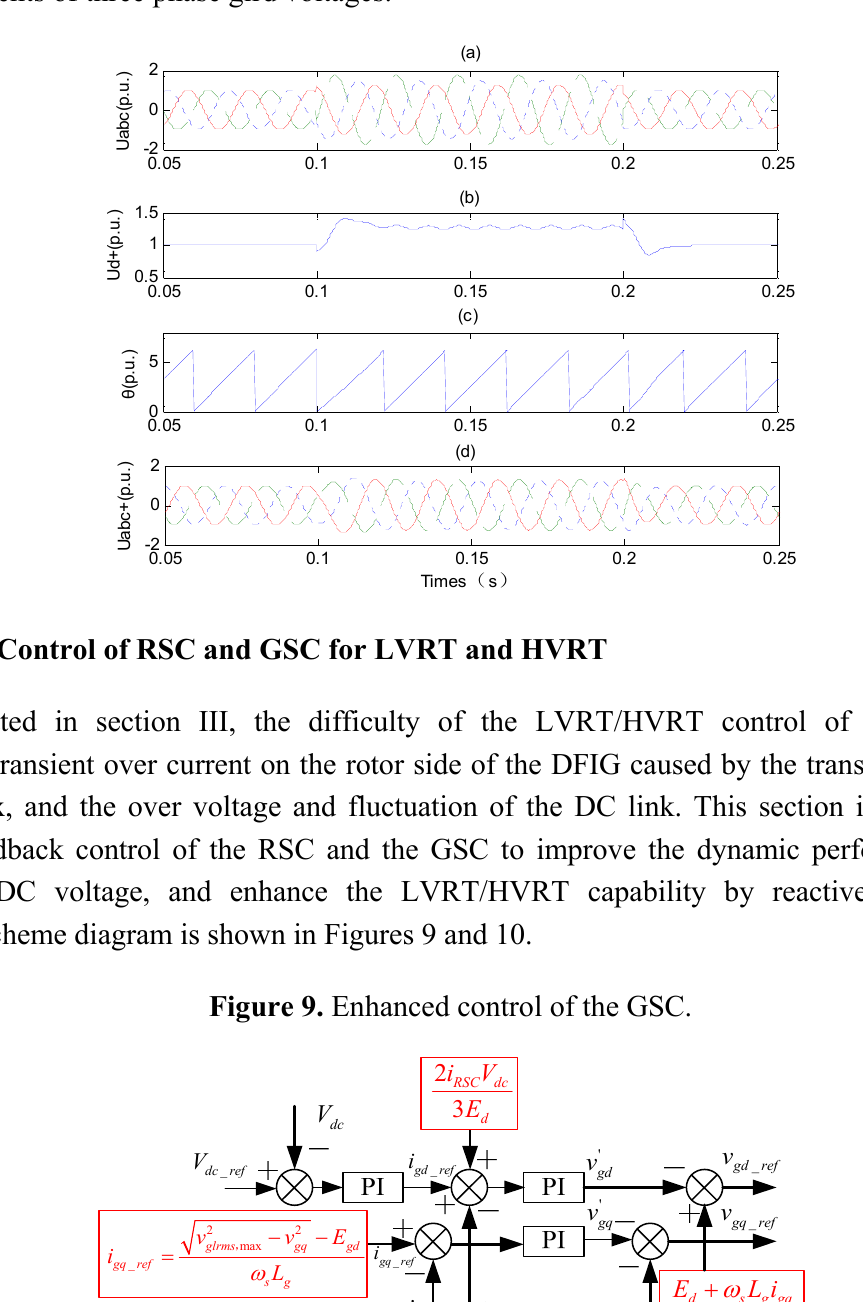
Figure 8. Simulation results for grid voltage detection method (positive sequence